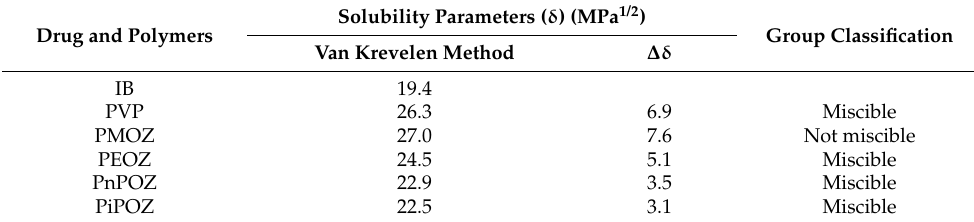
Table 2. Solubility parameters of drug and polymers. Drug and Polymers